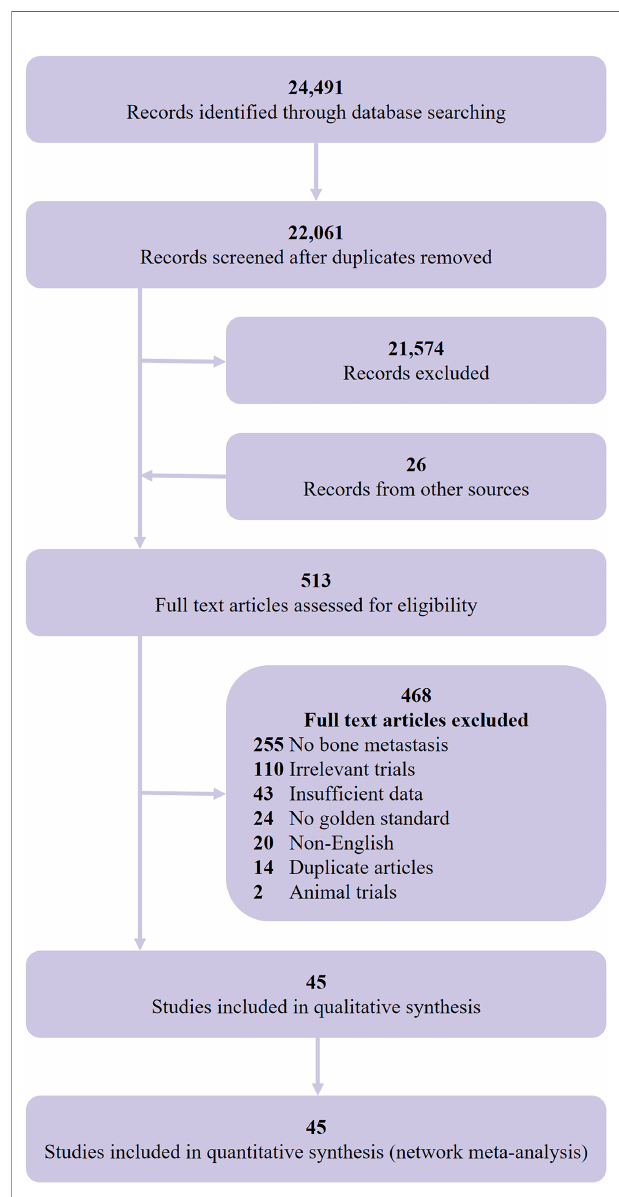
FIGURE 1 | Selection fl ow chart for studies included in the network